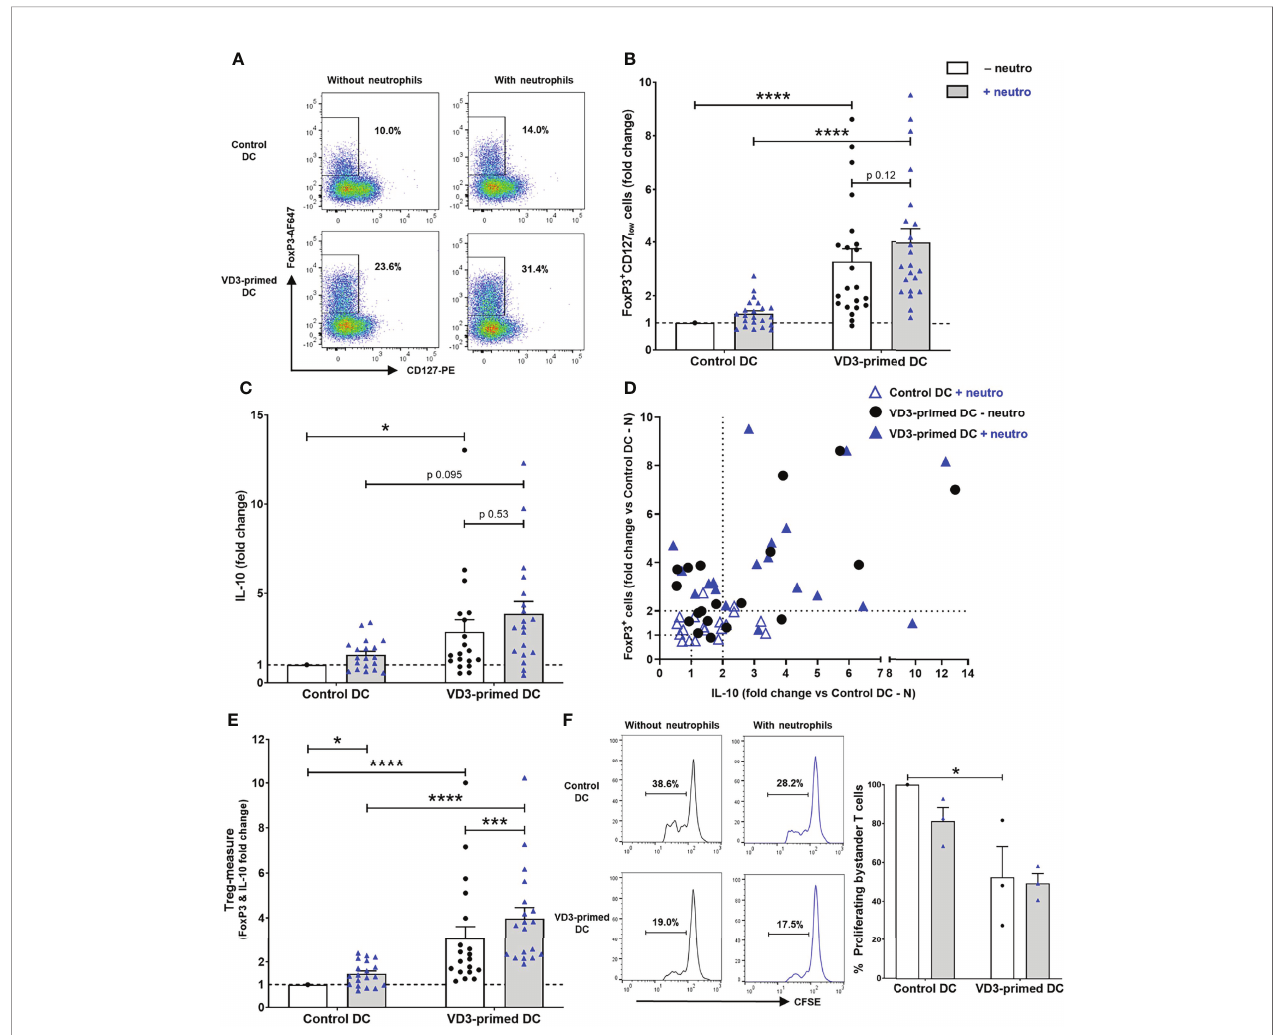
FIGURE 2 | Treg development induction by VD3-primed DCs is increased by the presence of neutrophils. (A) Representative fl ow cytometry plots of FoxP3 and CD127 expression in CD4 + T cells cultured with control or VD3-primed DCs in the presence or absence of autologous neutrophils are depicted. (B) The percentage of FoxP3 + CD127 low cells normalized to control DCs without neutrophils from 22 independent experiments is shown. (C) IL-10 production by T cells is shown relative to control DCs without neutrophils ( n = 19). (D) The induction of FoxP3 + cells ( y -axis) and IL-10 secretion ( x -axis) normalized to control DCs without neutrophils is depicted per condition. (E) Fold change of FoxP3 + and IL-10-producing T cells versus control DCs without neutrophils is combined as a Treg measure. (F) The suppressive capacity of T cells cultured with control or VD3-primed DCs with or without neutrophils. Results are representative (left panel) or the mean ± SEM of the percentage of proliferating bystander cells relative to control DCs without neutrophils of three independent experiments (right panel). Bar graphs show mean ± SEM. Friedman tests with Dunn ’ s post hoc test were performed in (B, C, F) , and one-way ANOVA with Holm – Sidak ’ s post hoc test was performed in (E) . * p < 0.05, *** p < 0.001, **** p <